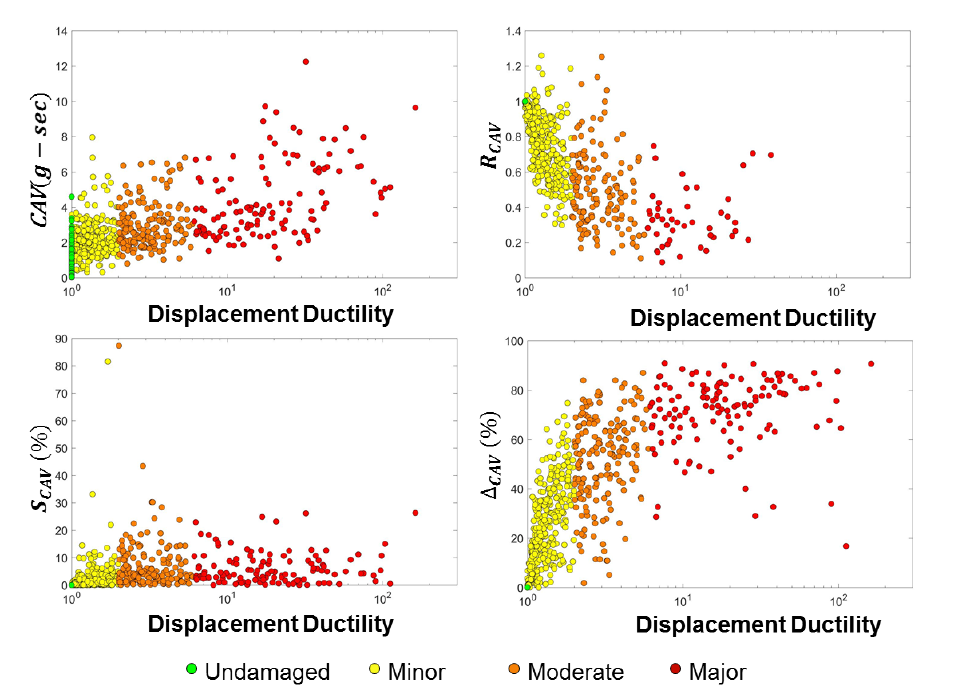
Figure 5. Plots of the relationships of the proposed features and the displacement